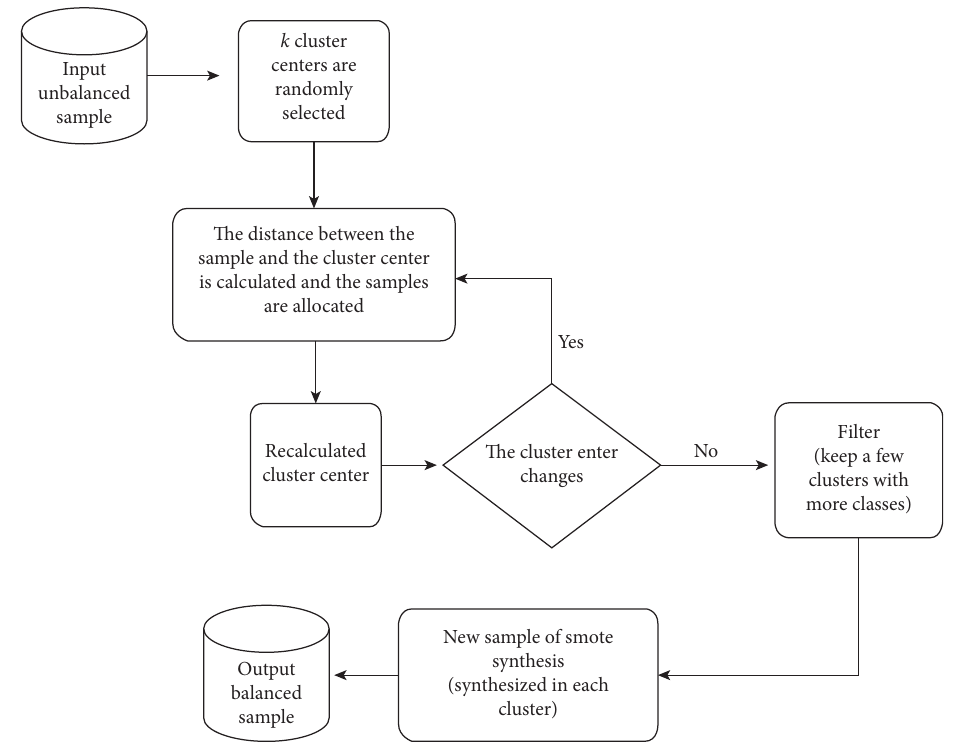
Figure 1: k- means SMOTE algorithm flowchart.